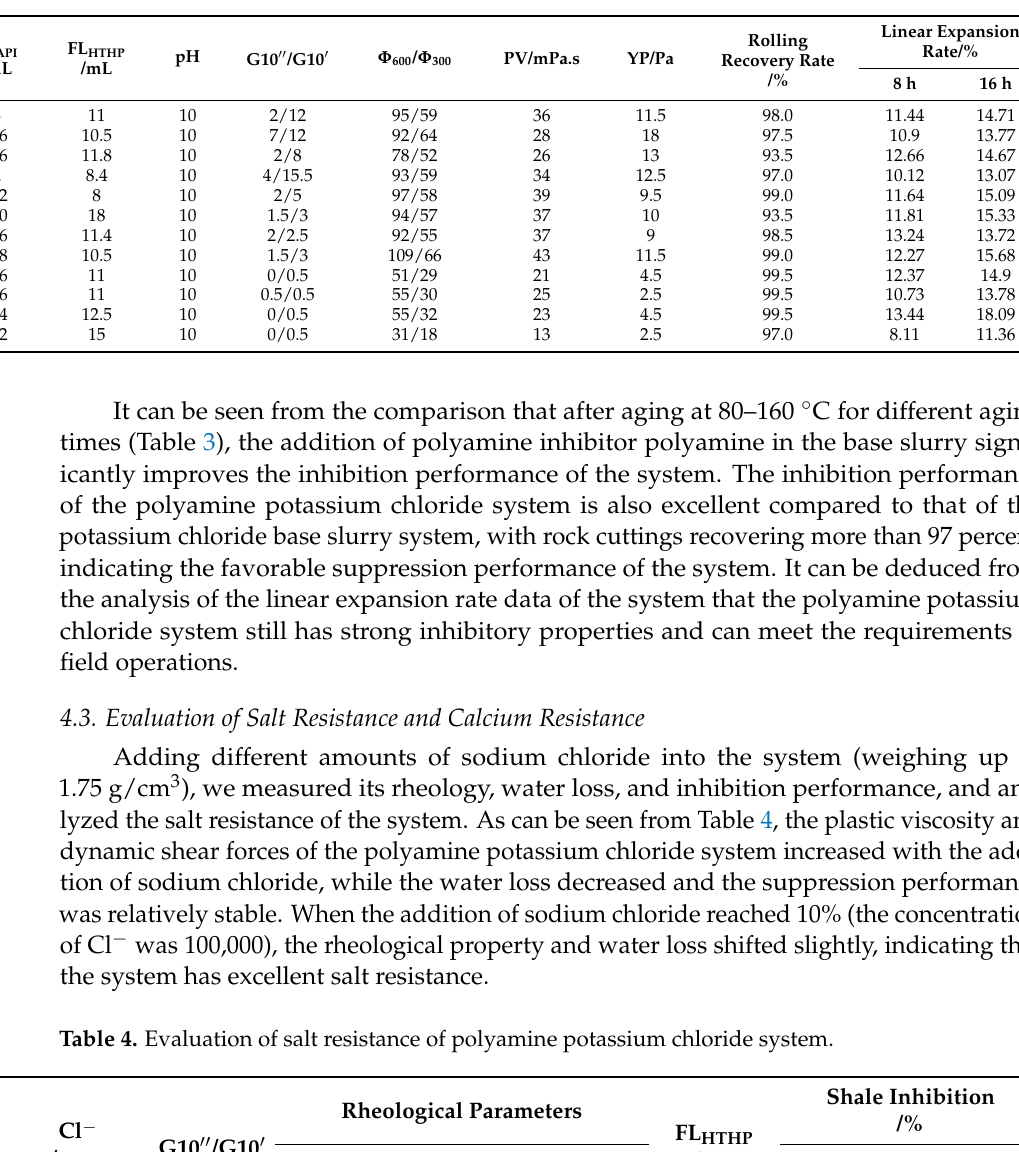
Table 3. Experimental evaluation of rheology, water loss and aging test.